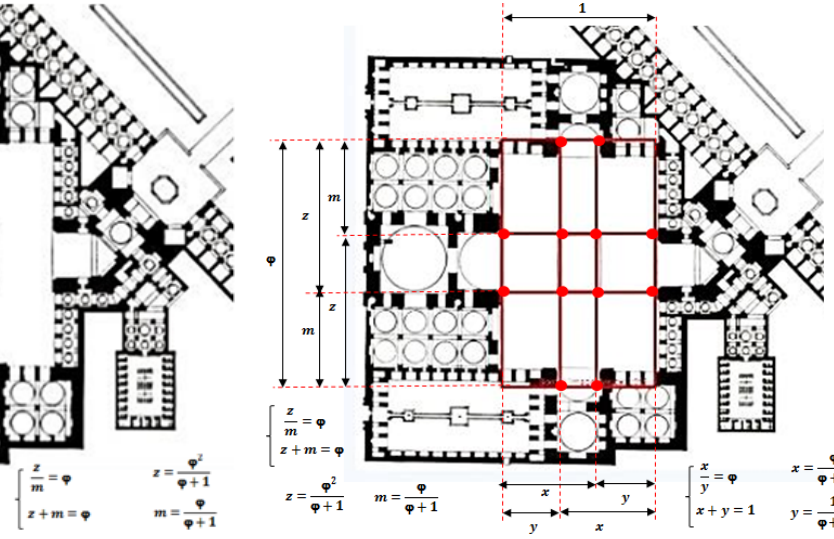
Figure 6: Adaptation of the space below the main dome with a golden rectangle and the separation walls on the golden distances